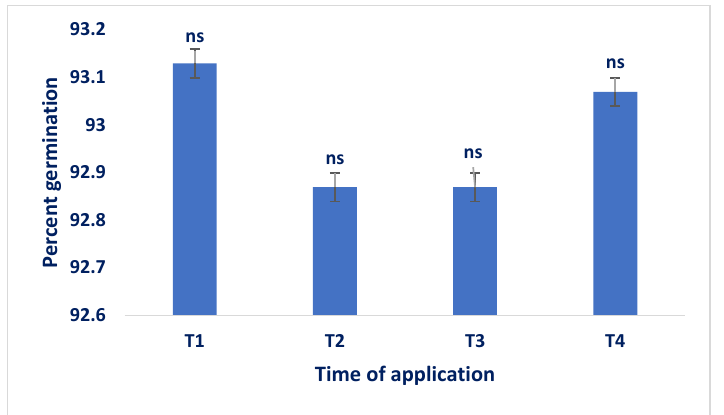
Figure 2. Effect of time of application of GA 3 during cultivation on the percent of germination of produced cauliflower seeds. ns = not significant, T 1 = GA 3 application at 3 weeks after transplanting, T 2 = GA 3 application at 4 weeks after, T 3 =GA 3 application at 5 weeks after transplanting, and T 4 = GA 3 application at 6 weeks after transplanting. The interaction effect between GA 3 and time of application during cultivation signif- icantly influenced the percentage of germination of produced cauliflower seeds. The high- est germination percentage (95.67%) of cauliflower seeds was obtained from the G 3 T 2 treatment during cultivation, and the lowest germination percentage (90.00%) was ob- tained from the G 1 T 4 treatment during cultivation which was statistically similar to G 0 T 2 treatment during cultivation. The percent germination of cauliflower seeds ranged from 90.00% to 95.67%. Application of gibberellic acid had minor influences on the seed germi- nation albeit it was statistically significant (Figure 3). Singh et al. (1976) found 83% germi- nation of cauliflower seed with the application of Ethrel @ 150 ppm.